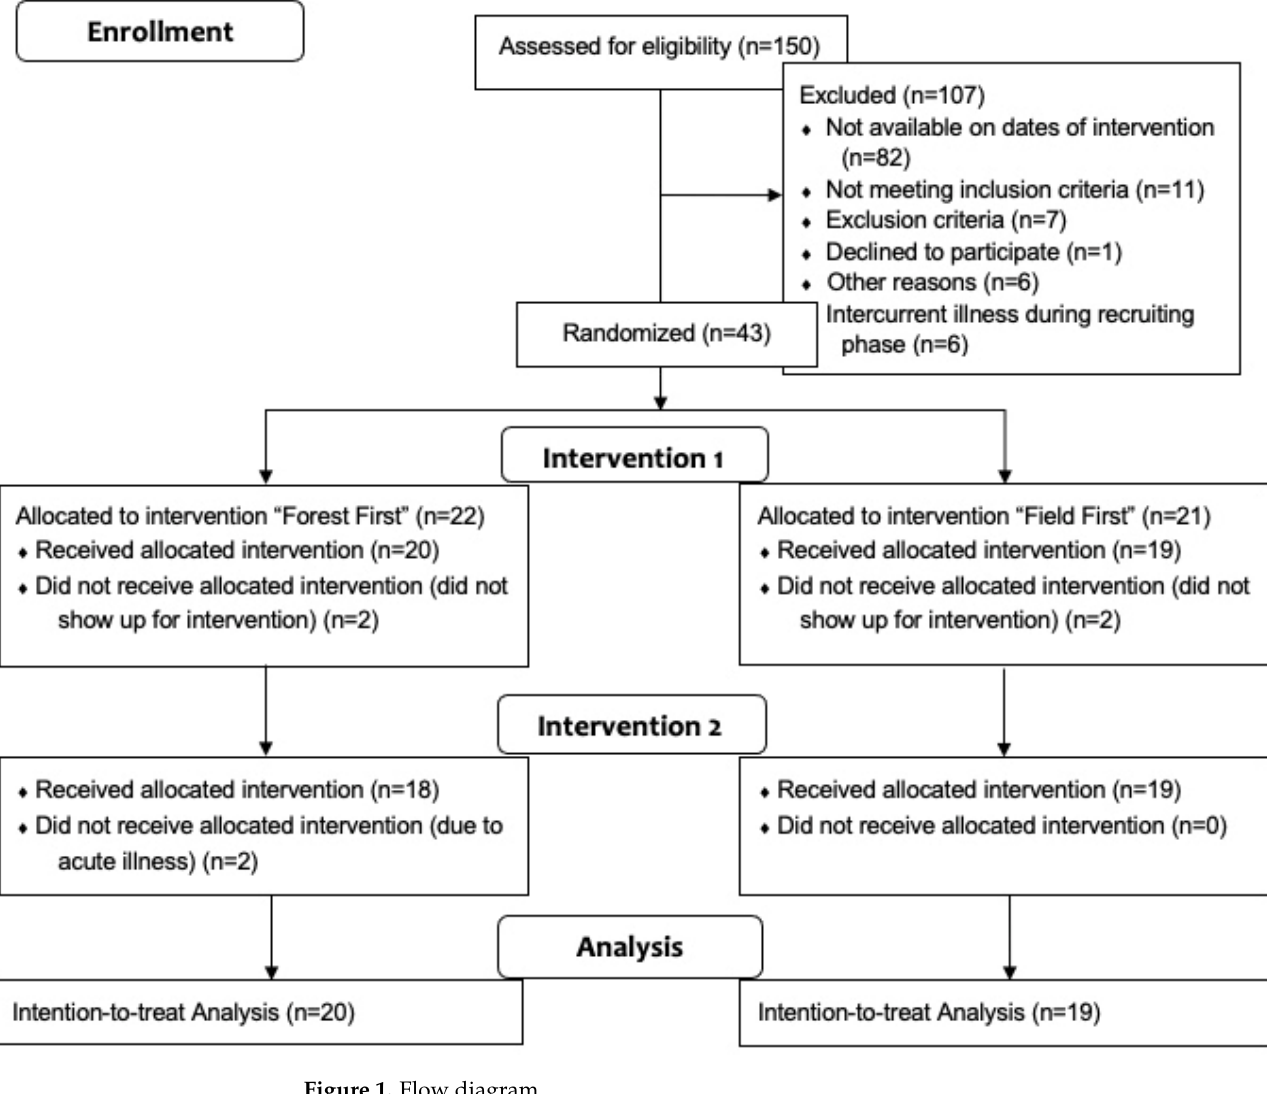
Figure 1. Flow diagram. Table 1. Group